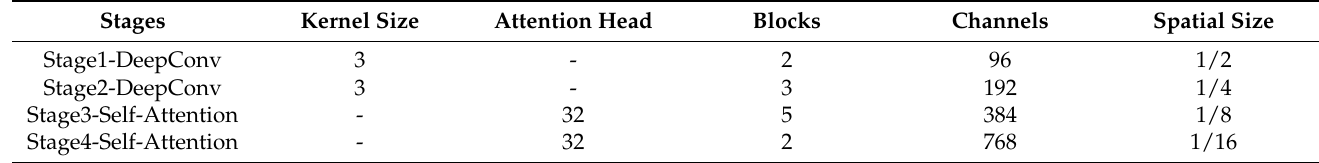
Table 1. Specific parameter description of the progressive context-aware aggregation module.